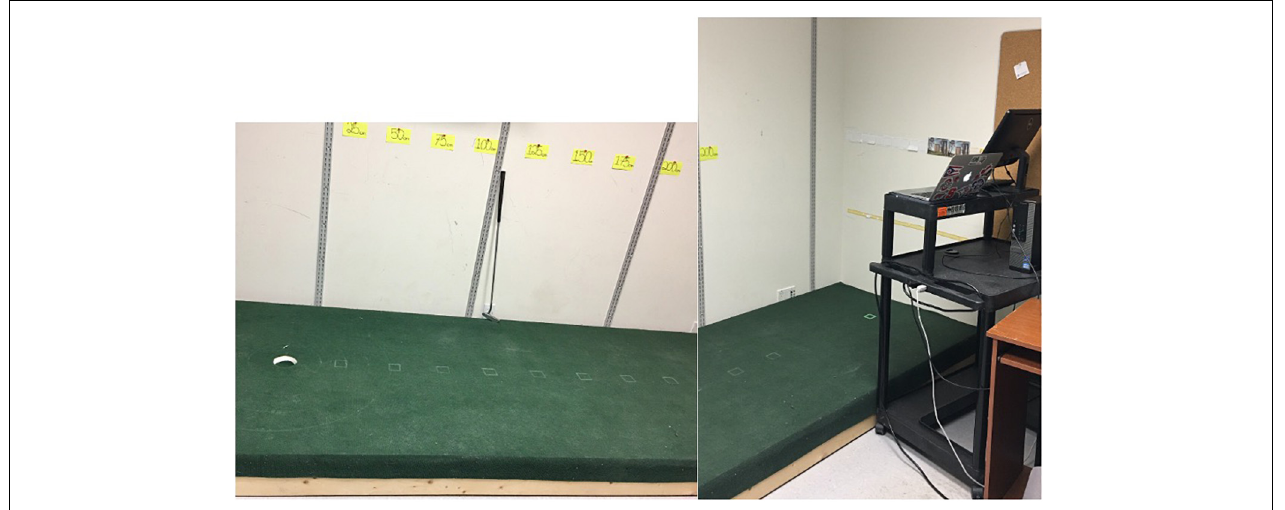
FIGURE 1 | The putting green with the MacBook and Dell computer on the standing cart, located toward the back end of the putting green.